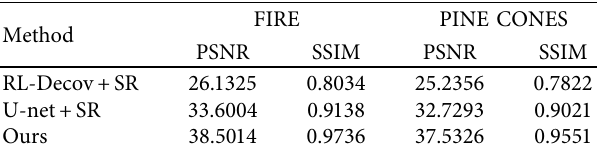
Figure 5: Experimental results on the PINE CONES dataset. (a) Image obtained by the × 5 objective with the process of the defocused blur. (b–d) Processed image of (a) by the RL-Decov+SR, U-net+SR, and our method, respectively. (e) Images obtained by the × 10 objective. (f–j) Enlarged images of the solid red region enclosed in (a–e), respectively. (k–o) Enlarged images of the solid blue region enclosed in (a–e), respectively. Table 1: Quantitative comparison with other methods on the test dataset.